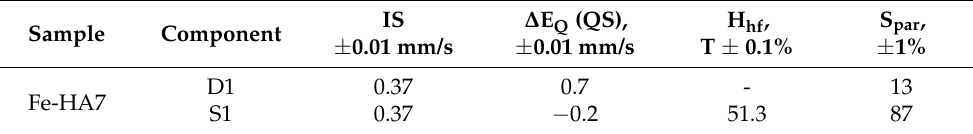
Figure 8. The Mössbauer spectrum of the Fe-HA7 sample was acquired at room temperature. Table 4. Parameters of mathematical processing of the Mossbauer spectra of the Fe-HA7 sample obtained at room temperature (isomer shift, IS; quadrupole splitting, QS, hyperfine field, H hf ; partial area, S par